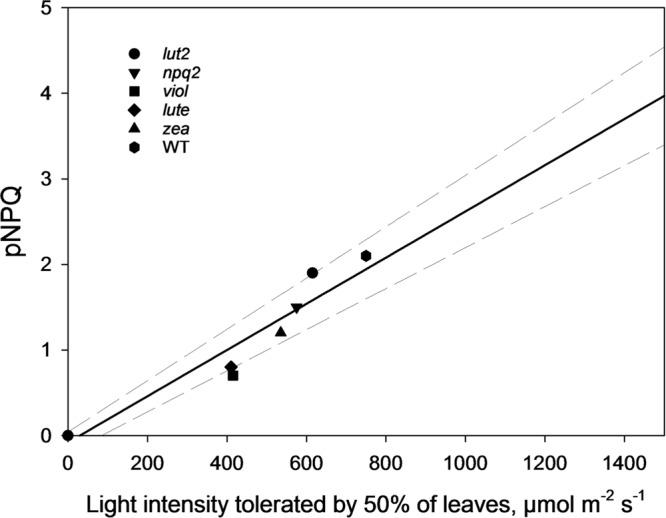
The pNPQ value which protects each genotype, taken from Figure 3, and the light intensity which causes photoinhibition in 50% of leaves for that genotype. Regression analysis was performed using SigmaPlot 12.0 (Linear, f = y0+a∗x). lut2 – no lutein, npq2 – no violaxanthin and neoxanthin, viol – violaxanthin only, lute – lutein only, zea – zeaxanthin only, WT – wild type.